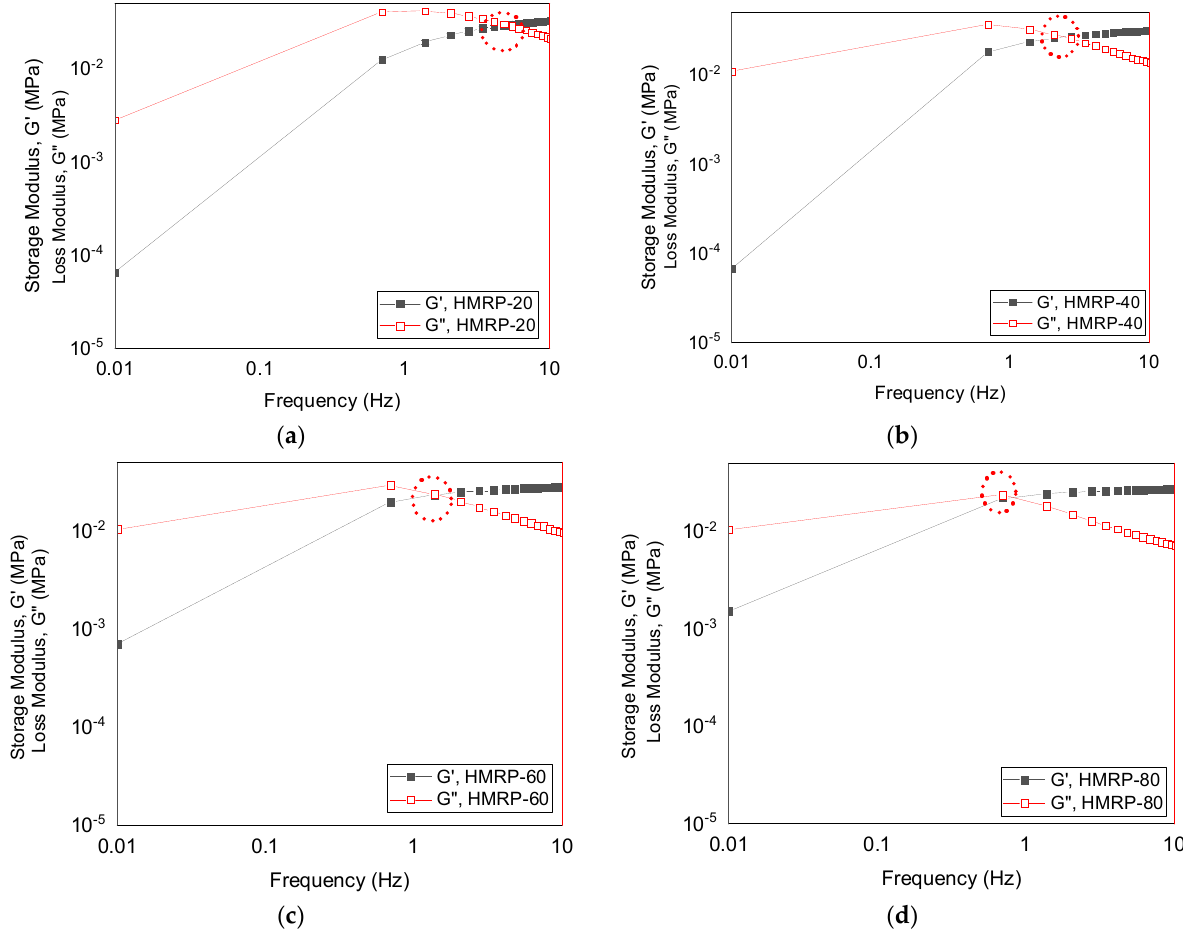
Figure 3. Shear storage and loss modulus of PVA-based MRP samples with different ratios of DMSO:water content with continuously changes in shear frequencies for ( a ) HMRP-20, ( b ) HMRP-40, ( c ) HMRP-60 and ( d ) HMRP-80.